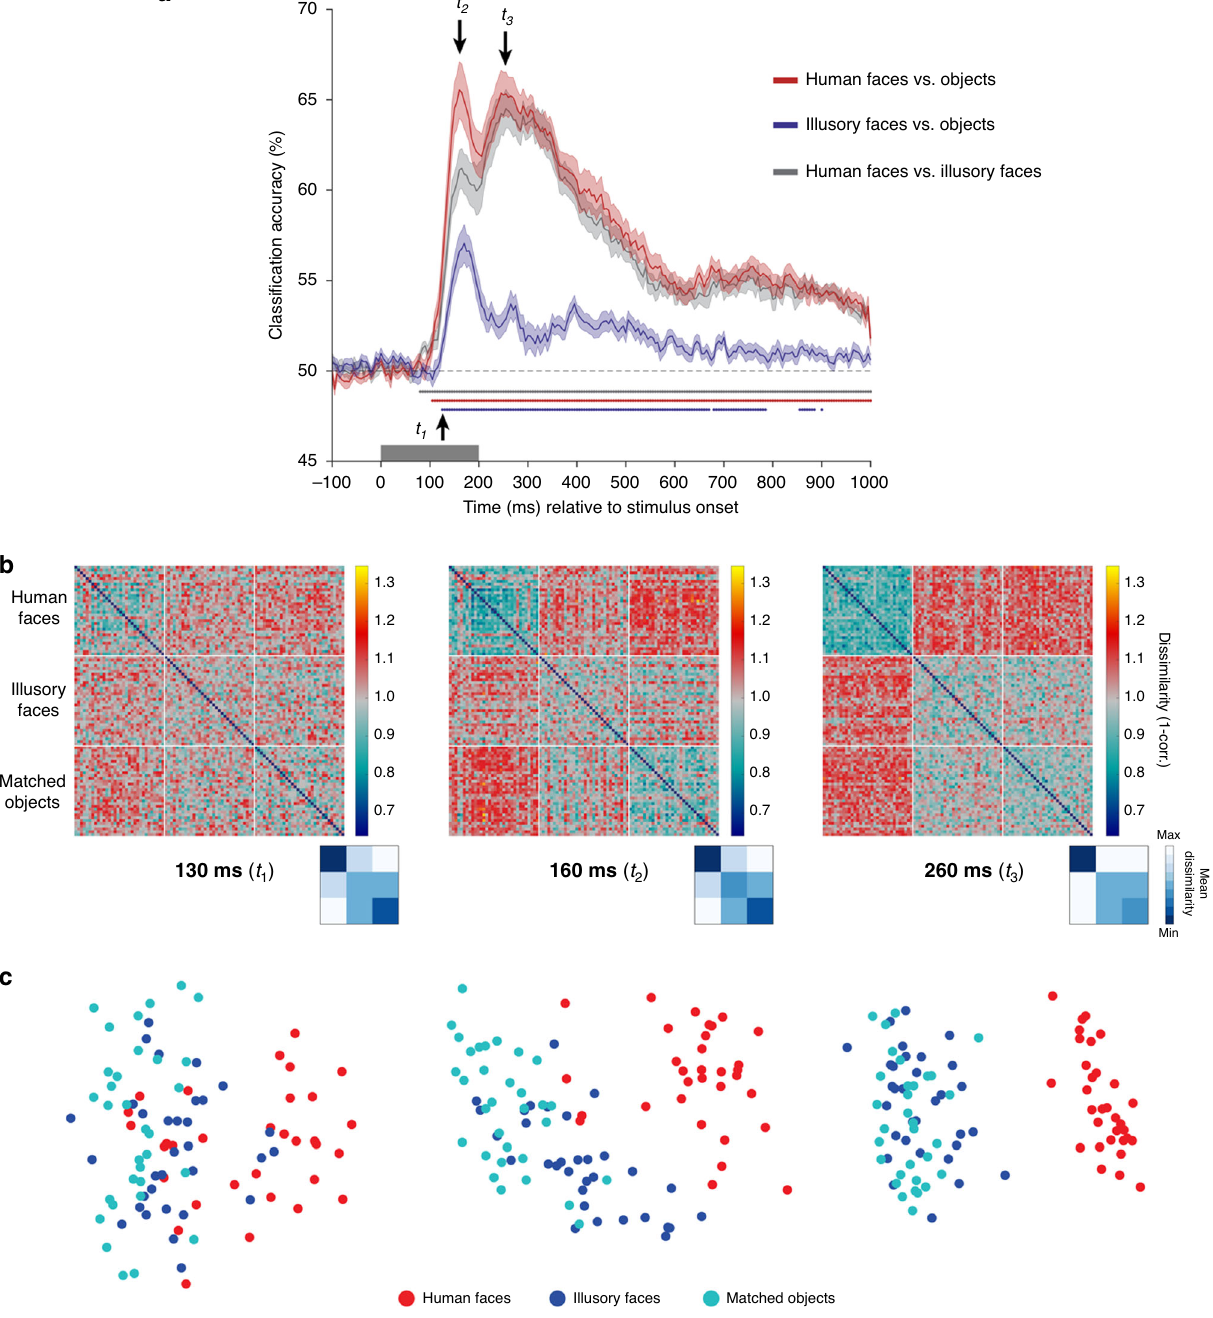
Fig. 5 MEG results showing a rapid transformation in the representation of illusory faces over time. a Cross-decoding results across time for all three category comparisons. Mean classi fi er performance is plotted across time relative to stimulus onset, averaged over N = 22 participants. Shaded area represents SEM. Multiple comparisons were controlled for using Threshold-Free Cluster Enhancement as implemented in CoSMoMVPA 26 . Stimulus duration is indicated by the gray bar from 0 – 200 ms on the x -axis. Chance performance is 50%, indicated by the dashed line. Colored disks along the x -axis indicate statistically signi fi cant timepoints. By 130 ms ( t 1 ) from stimulus onset, all three comparisons can be signi fi cantly decoded. There is an initial peak at ~160 ms ( t 2 ) for all comparisons, and a second peak ~260 ms ( t 3 ) for decoding human faces from all objects with or without a face, that is absent for decoding illusory faces from matched objects. These three timepoints of interest are used as the focus for the subsequent analyses. Source data are provided as a Source data fi le. b Representational dissimilarly matrices (96 × 96) for all stimuli for the three timepoints of interest (130, 160, and 260 ms post stimulus onset). The dissimilarity is calculated by taking 1-correlation (Spearman) between the MEG activation patterns for each pair of stimuli. The colorbar range is scaled to the max and min of the dissimilarity values across all timepoints for visualization (see Supplementary Movie 1 for complete time-varying RDM). White lines indicate stimulus category boundaries. Insets show 3 × 3 matrices for each time point averaged by category, excluding the diagonal. Source data are provided as a Source data fi le. c Visualization of the dissimilarity matrices in ( b ) using multidimensional scaling. The fi rst two dimensions following MDS are plotted. Each of the points representing the 96 stimuli is colored according to its category membership. Proximity of the points represents more similar brain activation patterns for the associated